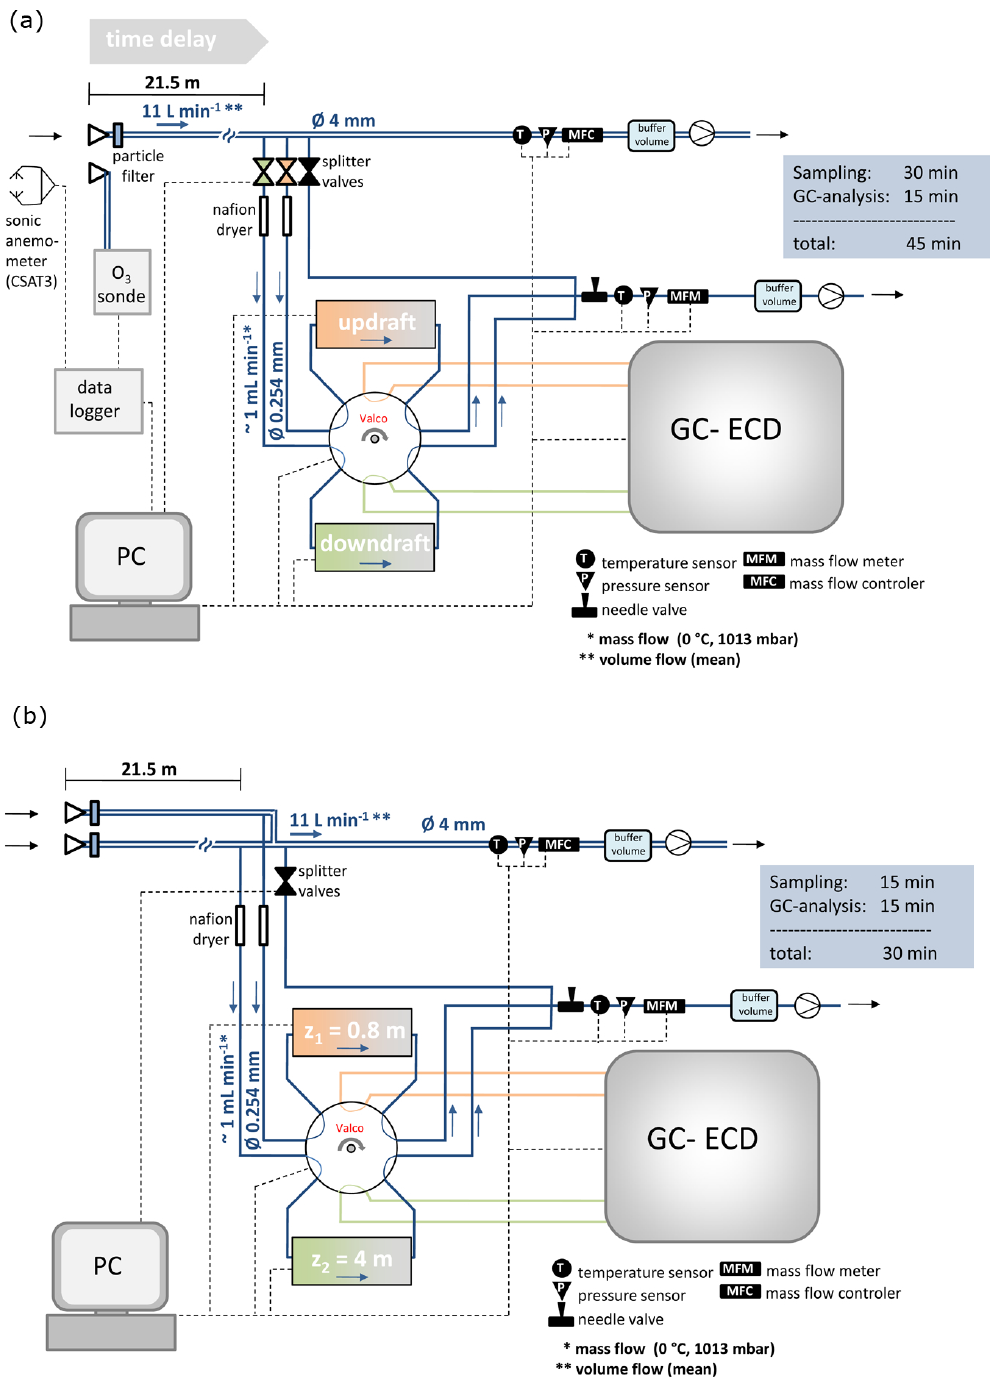
Figure 2. Setup of the PAN flux measurement system showing the inlet system, the pre-concentration units, the GC-ECD for PAN analysis, the data acquisition and control as well as additional measurements. (a) Operation in the HREA mode: the system contains one inlet line, and subsamples are drawn according to the sign of the vertical wind velocity into the PCUs acting as reservoirs. The hyperbolic dead band is calculated using the signal of a high-frequency O 3 analyser. (b) Operation in MBR mode: two separate inlet lines are employed, and the system is capable of simultaneously sampling at two inlet heights and performing subsequent analysis of